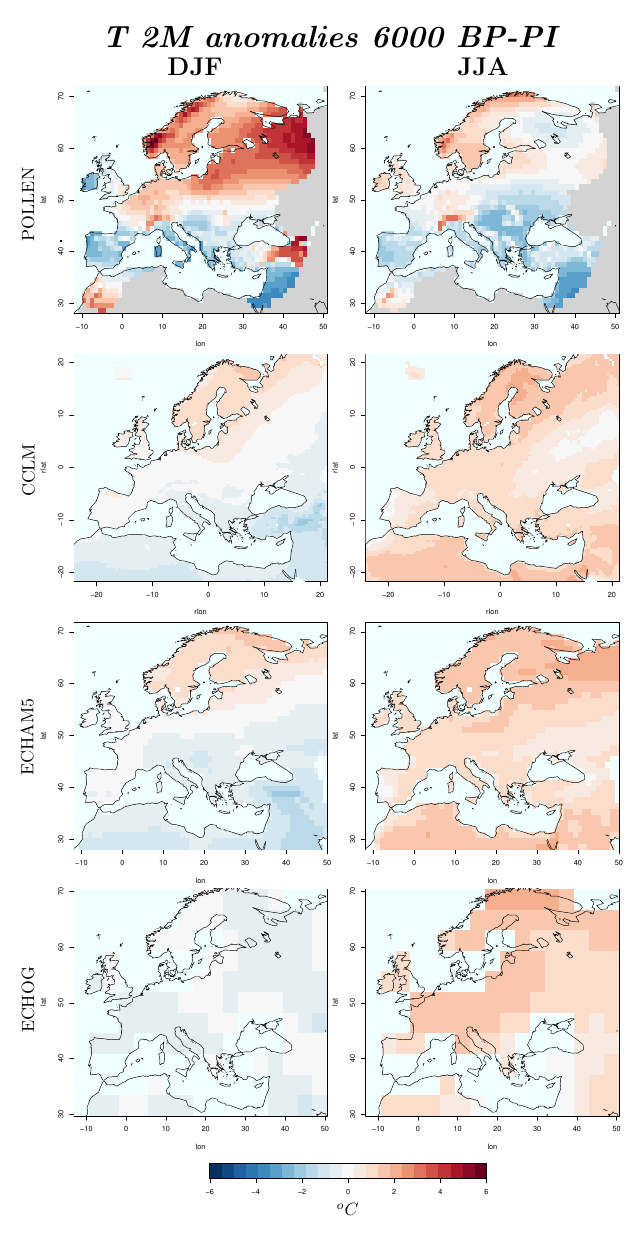
Figure 6. Maps of the anomalies between 6000BP and the prein- dustrial period of Winter (left) and Summer (right) seasonal means of 2m temperature, calculated over a 25-year period. The results of the three different models and the pollen-based reconstructions are presented. From top to bottom: POLLEN-based reconstructions, CCLM, ECHAM5, ECHO-G. The results are presented on each data set original grid: the CCLM data, in particular, are shown in rotated geographical